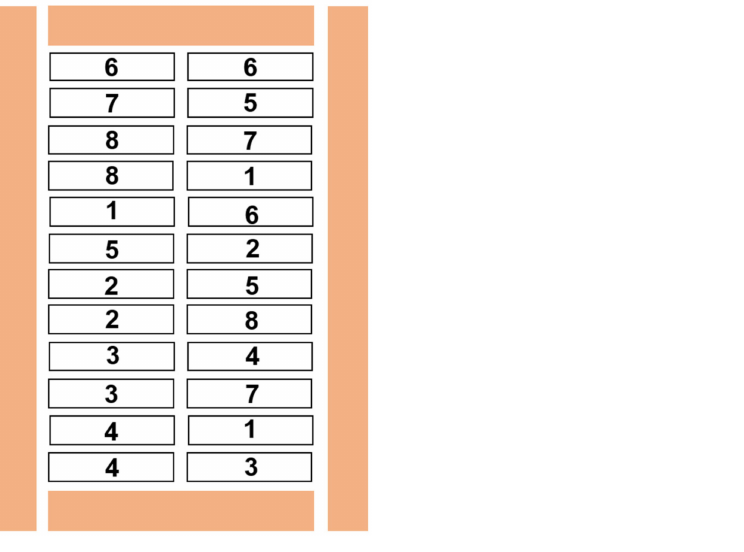
Figure 1. Diagrammatic field layout of the experiment. The field was divided into 24 plots, each 12 m in length and 1.55 m in width. The interval between each plot is 20 cm, and guard raw were set around the experimental plots (the orange cases). Numbers 1–8 represent the different treatments, and the same numbers represent three replicates of the experimental